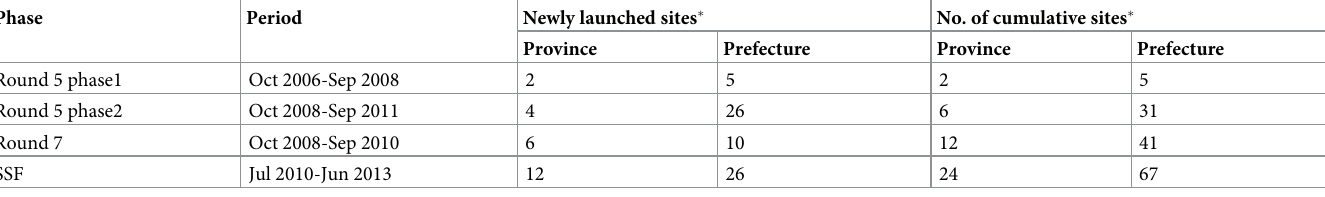
Table 1. Implementation of GFPMDT project in a phased manner in China from October 2006 to June 2013.